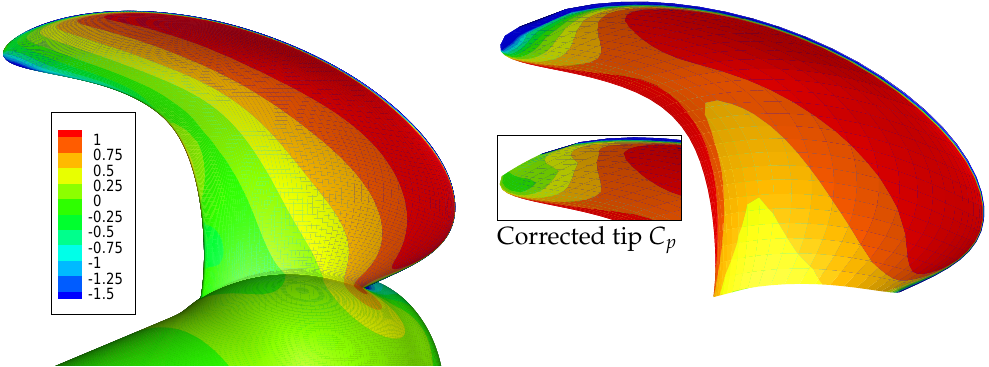
Figure 8. Pressure coefficient, C p , on the pressure side for J = 0.37, RANS ( left ) BEM ( right ). The insert figure shows the BEM pressure distribution after the tip pressure correction.